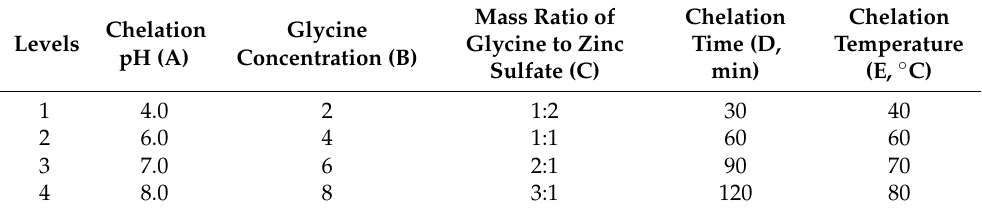
Table 5. Orthogonal experimental factor level values for Zn − Gly